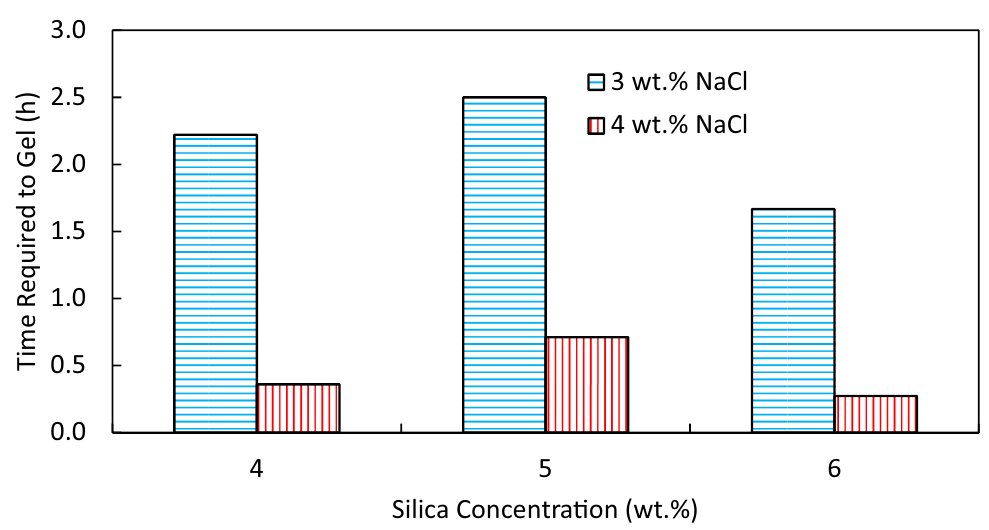
Figure 7. Time required to gel (complete gelation time by bottle tests—start time of gelation by absorbance measurements) for different solid gels formed from different concentrations of silica and NaCl in